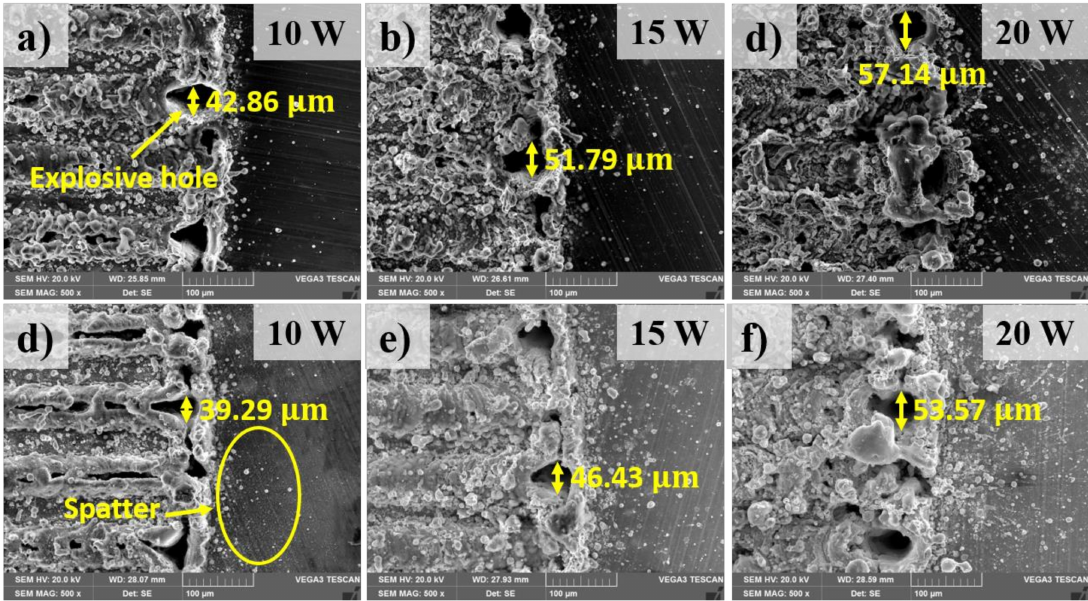
Figure 7. SEM images at the boundary of the welding zone on the top surface. ( a – c ): Welding without the metal tube; ( d – f ): Welding with the metal